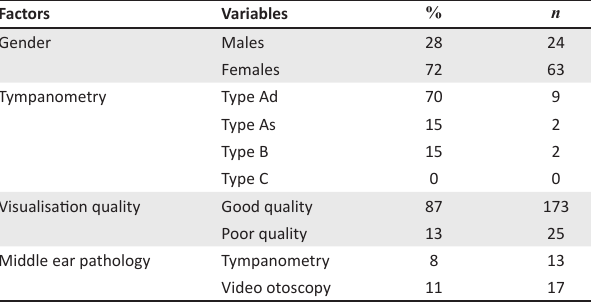
TABLE 1: Summary of results.